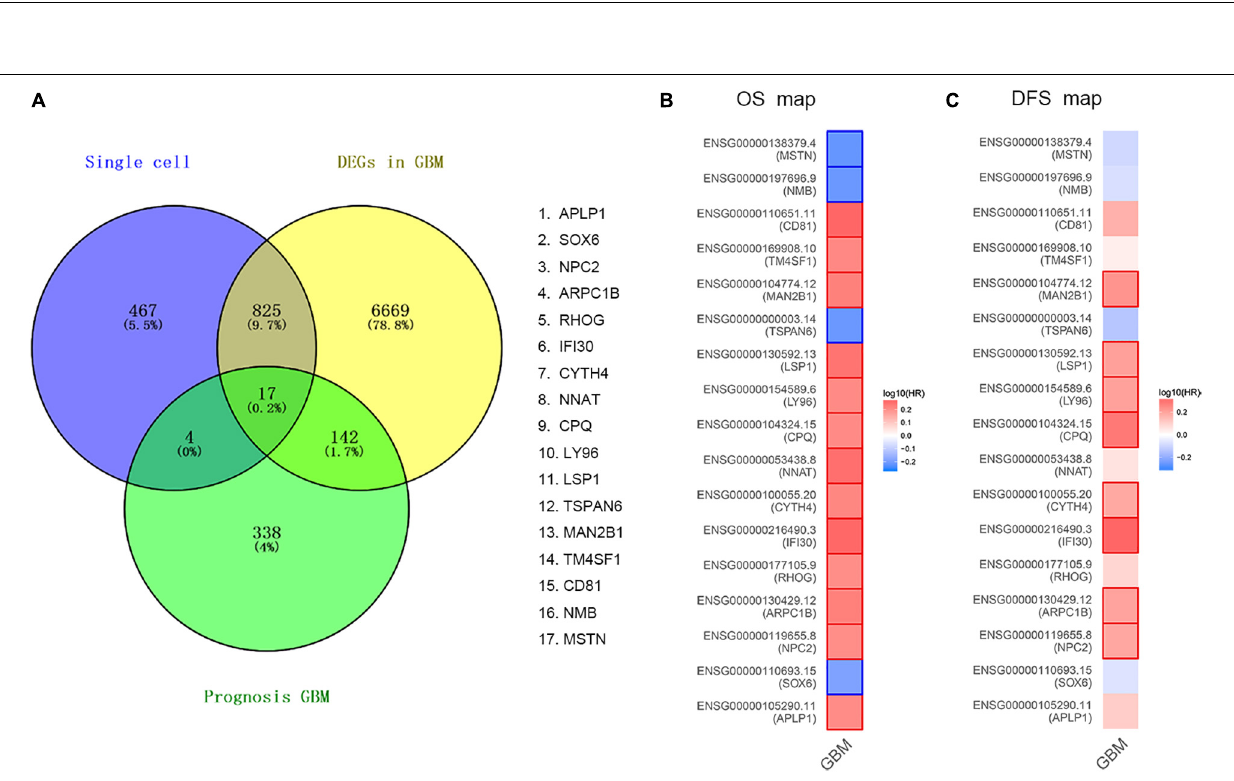
FIGURE 1 | Cell clusters and cell types distribution in six GBM tissue sample. (A) A total of 14 cell clusters was identified and shown with t-SNE maps in six GBM tissue samples. (B–D) T-SNE map showing canonical markers for three cell types: microglia (B) , oligodendrocytes (C) , and glioma stem cells (D) .